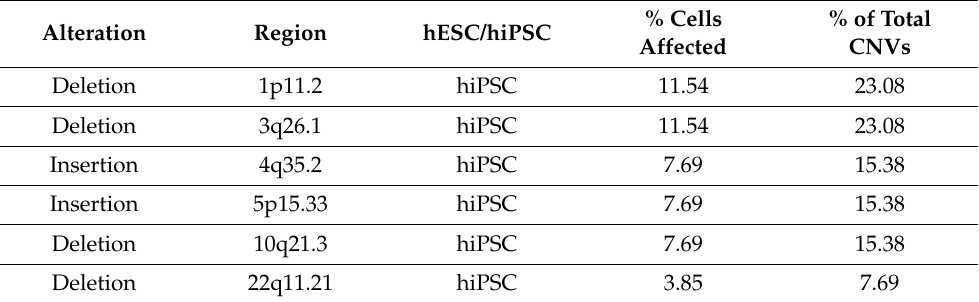
Table 3. List of Copy Number Variations (CNVs) detected by CGH array (aCGH) in hPSCs.